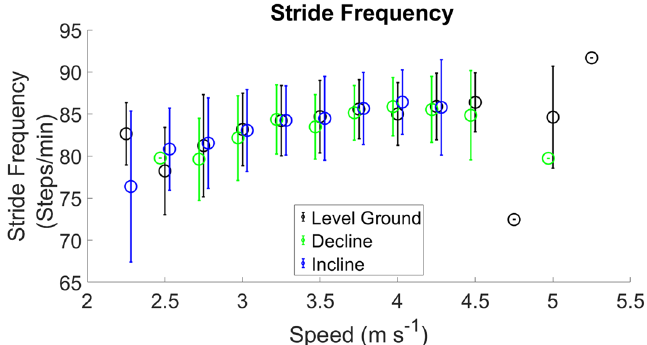
Figure 4. Stride Frequency measured from the force sensing insoles, across the range of velocities and